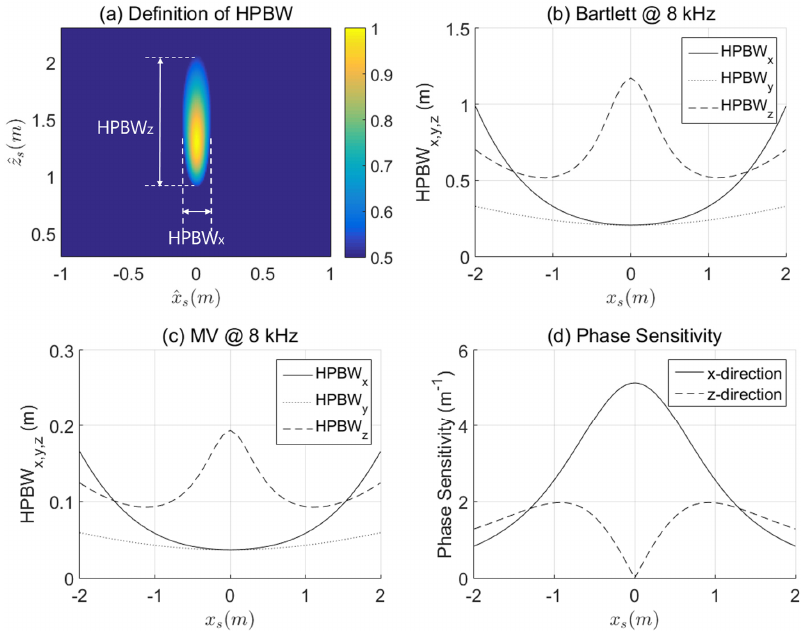
Figure 5. The definition of the half power beam width (HPBW) ( a ) and HPBWs simulated with respect to the source position at (cid:2200) (cid:3046) = ((cid:1876) (cid:3046) ,0.0 m,1.3 m) under the condition of 8 kHz and 0 dB SNR for the Bartlett processor ( b ) and for the minimum variance (MV) processor ( c ); The color bar in ( a ) represents the value of Φ((cid:2200)(cid:3548) (cid:3046) ) Φ((cid:2200) (cid:3046) )⁄ . The phase sensitivity simulated under the same condition is shown in ( d );